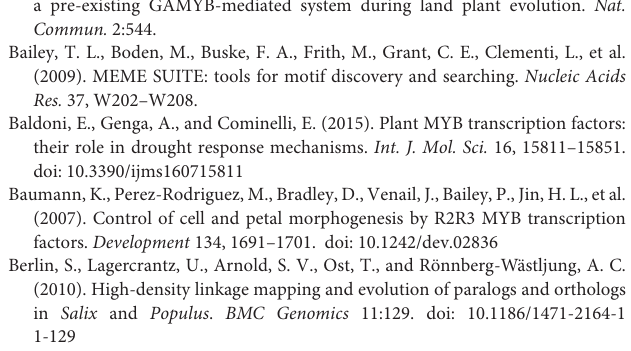
Supplementary Figure 1 | Maximum likelihood phylogenetic tree of poplar and willow R2R3 MYB genes. Supplementary Figure 2 | Distribution of exon lengths in poplar and willow R2R3 MYB genes. Supplementary Figure 3 | Distribution and numbers of different motifs in the poplar and willow R2R3 MYB genes. Supplementary Figure 4 | Neighbor-joining phylogenetic tree of poplar, willow, A. thaliana , P. patens , C. reinhardtii , grapevine, maize, B. napus , apple, and ginkgo R2R3 MYB genes. Supplementary Figure 5 | Maximum likelihood phylogenetic tree of poplar, willow, A. thaliana , P. patens , C. reinhardtii , grapevine, maize, B. napus , apple, and ginkgo R2R3 MYB genes. Supplementary Figure 6 | Cis-element analysis of the promoter regions of GAMYB genes. Supplementary Table 1 | List of 192 identified poplar R2R3 MYB transcription factors. Supplementary Table 2 | List of 216 identified willow R2R3 MYB transcription factors. Supplementary Table 3 | List of poplar R2R3 MYB paralogous gene pairs. Supplementary Table 4 | List of willow R2R3 MYB paralogous gene pairs. Supplementary Table 5 | List the poplar and willow R2R3 MYB orthologous gene pairs identified by OrthoFinder v2. Supplementary Table 6 | List of different cis-acting elements. Supplementary Table 7 | List of primer sequences used in qRT-PCR. Supplementary Table 8 | List different Motif sequences. Supplementary Sequence 1 | List of sequences of 192 poplar R2R3 MYB proteins. Supplementary Sequence 2 | List of the CDS sequences of 192 poplar R2R3 MYB proteins. Supplementary Sequence 3 | List of the sequences of 216 willow R2R3 MYB proteins. Supplementary Sequence 4 | List of the CDS sequences of 216 willow R2R3 MYB proteins. Supplementary Sequence 5 | List of the sequences of R2R3 MYB proteins from eight species: A. thaliana (126 members), P. patens (50 members), C. reinhardtii (10 members), V. vinifera (134 members), Z. mays (157 members), B. napus (249 members), M. domestica (228 members) and G. biloba (69